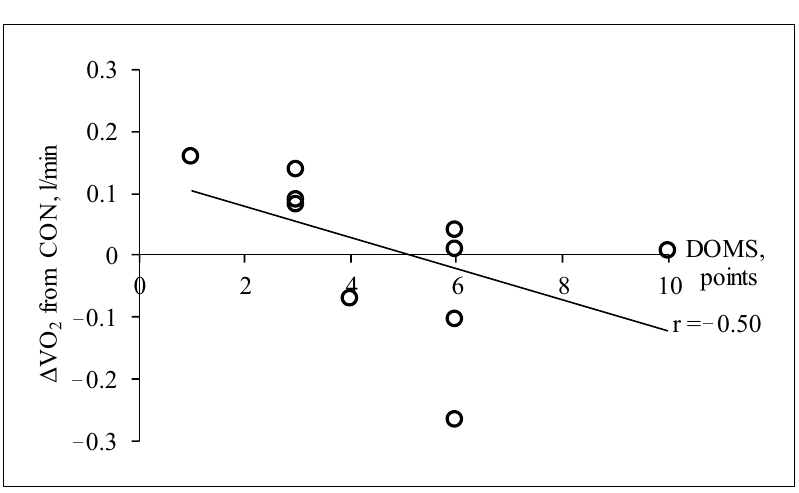
Figure 4. The correlation between changes (from control moderate cycling conditions (CON)) on oxygen uptake (ΔVO ) during moderate cycling 24 hours after prior drop 2 jumps and delayed onset muscle soreness (DOMS) 24 hours after prior drop jumps